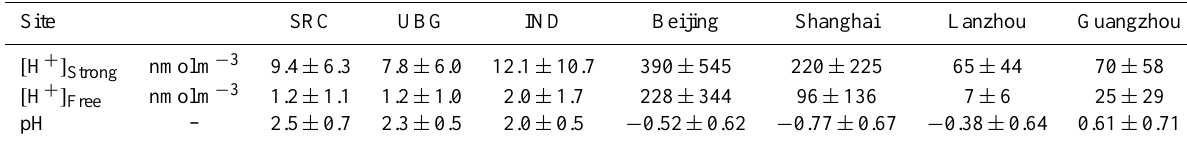
Table 2. Comparison of aerosol acidity between data observed in this study and in Pathak et al.